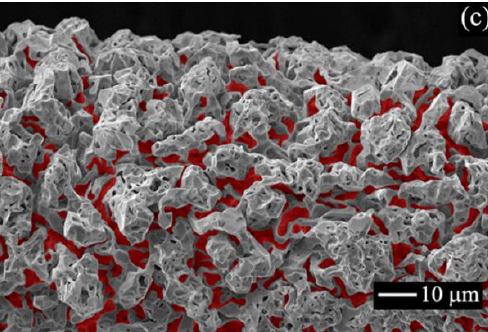
Figure 2. SEM images of the wire surface obtained at E 0 = 25 keV in SE mode for the fresh Pt–Pd–Rh– Ru gauze ( a ) and for the back ( b ) and frontal ( c ) sides of such gauze after NH 3 oxidation with air in a laboratory reactor at T ~1133 K and P ~3.6 bar for 50 h.